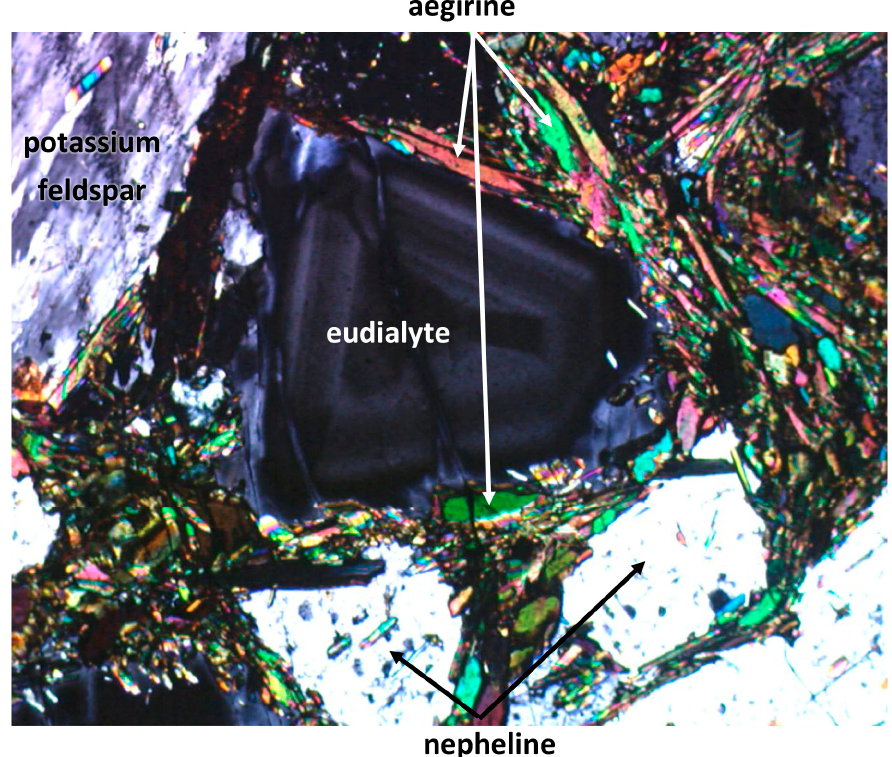
Figure 4. Association of liquidus minerals EGM, nepheline, microcline, aegirine (field of view 1.2